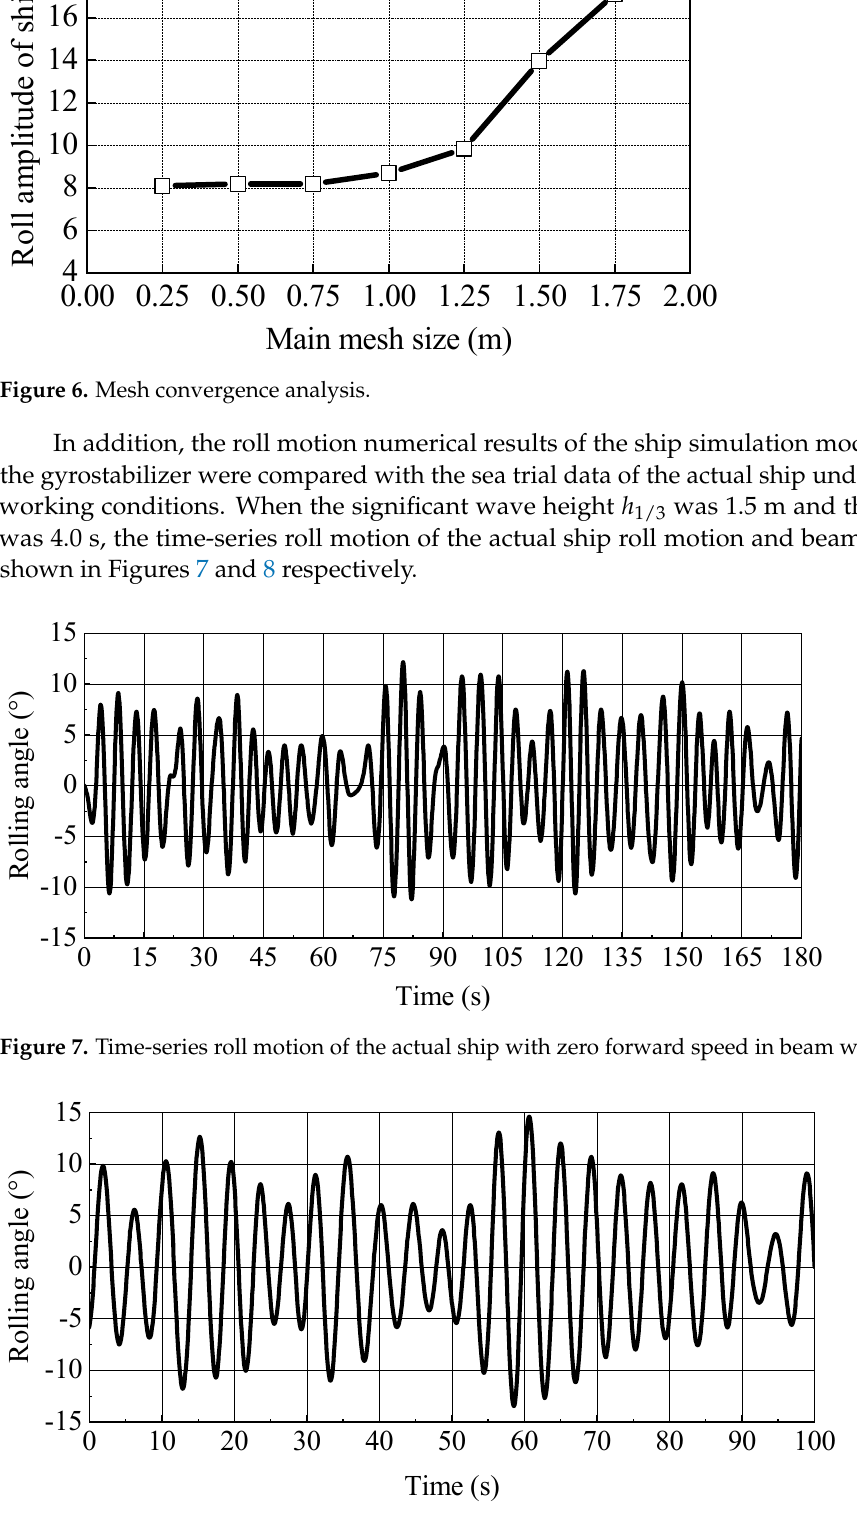
Figure 8. Time-series roll motion obtained by numerical simulation. It can be seen that the roll motion period of the ship in waves was consistent with the wave period. The average roll amplitude of the actual ship was 7.82 ◦ and the